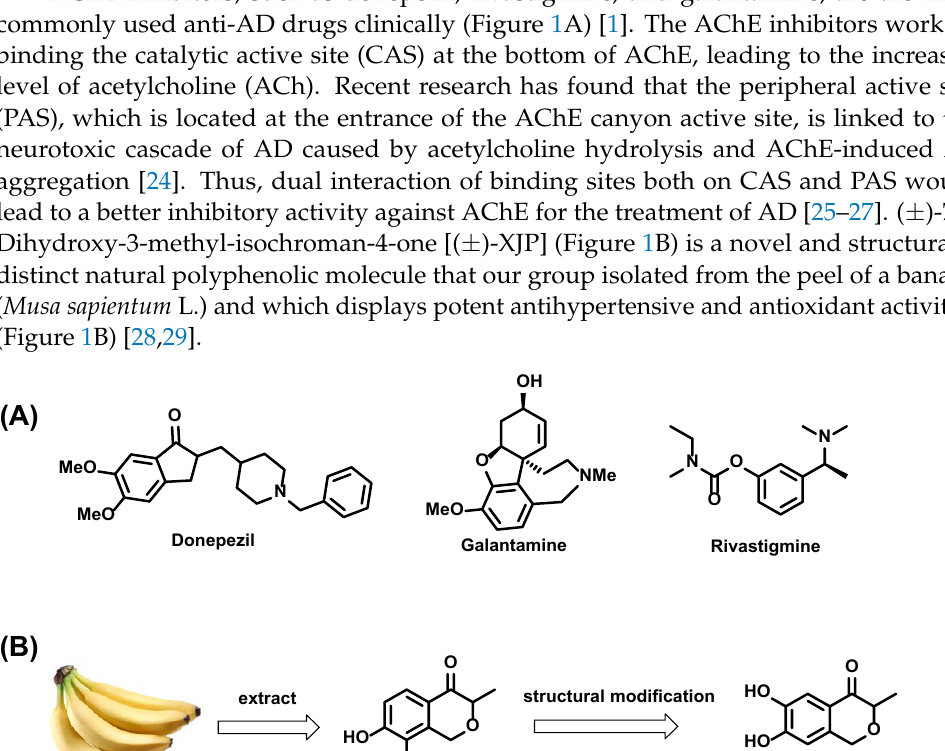
Figure 2. ( A ) Design strategy of the target compounds . ( B ) The pharmacophore of target compounds and the active pockets of AChE.